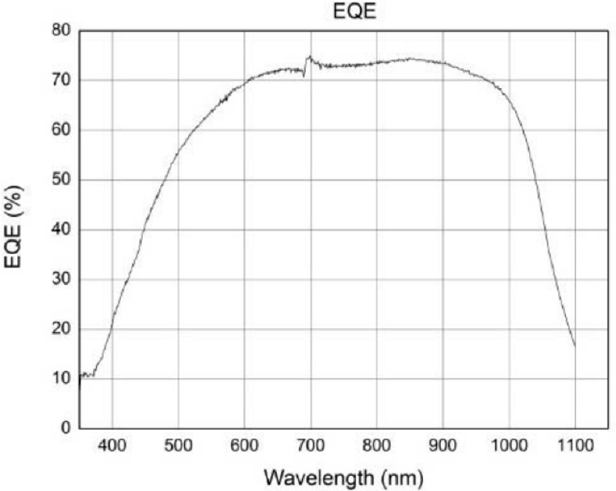
Figure 16. External quantum efficiency (EQE) of a silicon photovoltaic cell. Extracted from [13], our own elaboration.